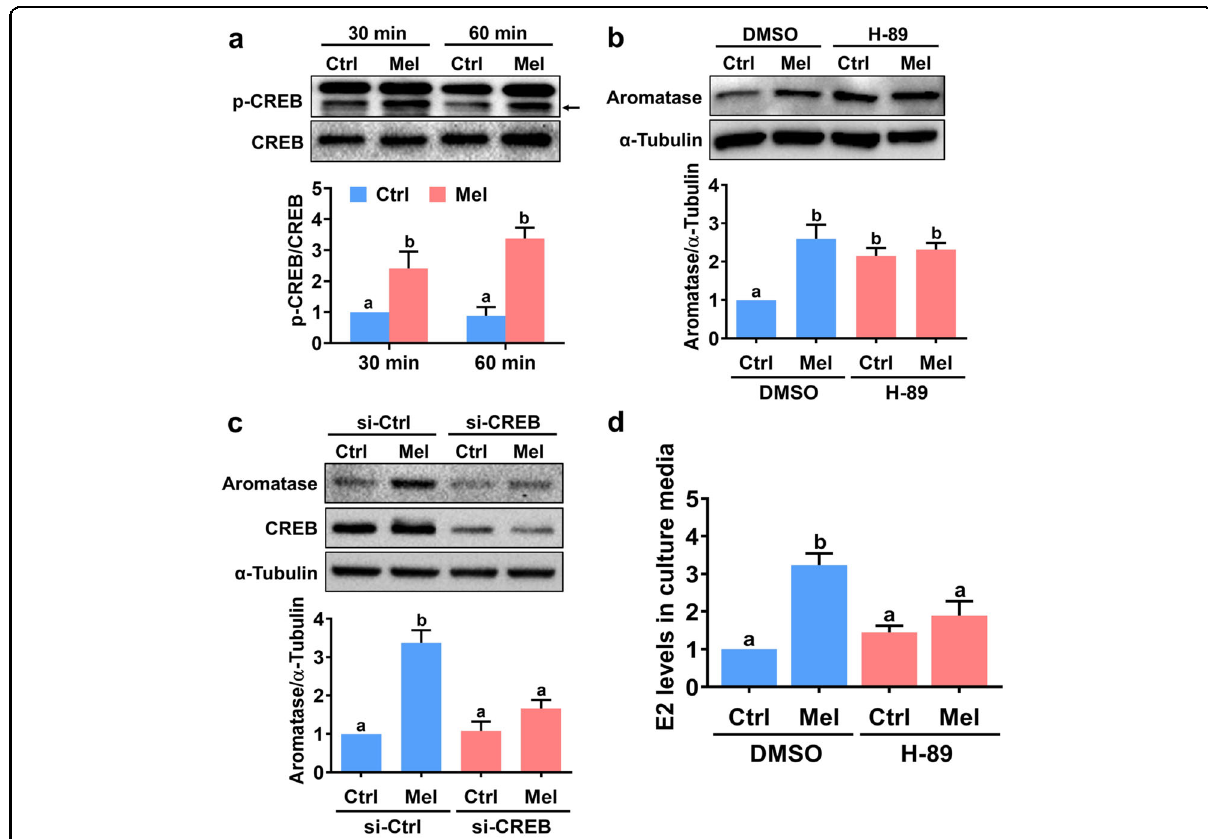
Fig. 3 Melatonin-stimulated aromatase expression is mediated by the PKA-CREB pathway in primary hGL cells. a Cells were treated with 500 µM melatonin for 30 or 60 min, and the expression of both phosphorylated and total CREB was determined by western blotting. b Cells were pretreated with vehicle control (DMSO) or 10 µM H-89 for 30 min and then exposed to 500 µM melatonin for 24 h. Aromatase protein levels were examined by western blotting. c Cells were transfected with 100 nM control siRNA (si-Ctrl) or CREB siRNA (si-CREB) for 48 h and then treated with 500 µM melatonin for 24 h. Aromatase protein levels were examined by western blotting. d Cells were pretreated with vehicle control (DMSO) or 10 µM H-89 for 30 min and then exposed to 500 µM melatonin for 24 h. E2 levels in culture media were examined by ELISA. The results are expressed as the mean ± SEM of at least three independent experiments. Values without a common letter are signi fi cantly different ( p <